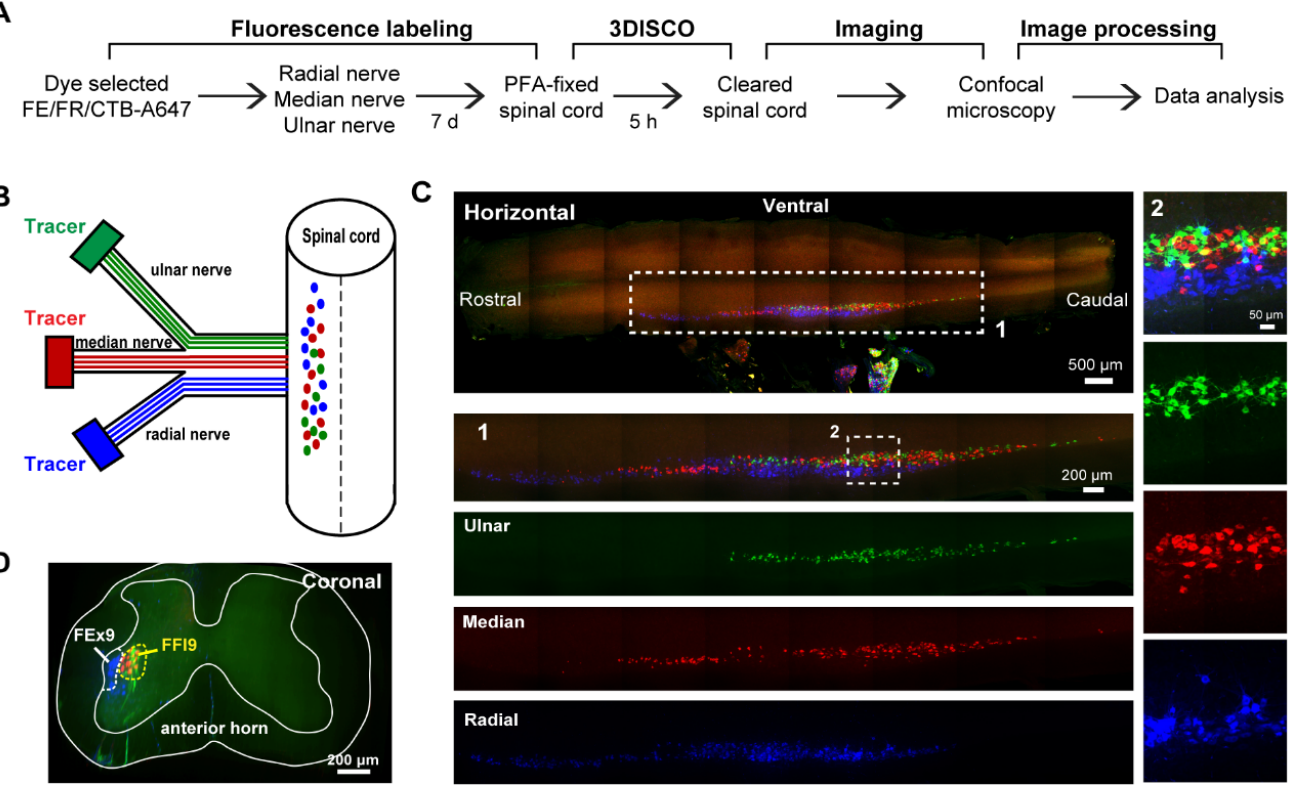
Figure 2. The 3D imaging of motor neurons of brachial plexus in the spinal cord. ( A ) The entire experimental process. ( B ) The screened tracers (FE, FR, and CTB-647) were used randomly to simultaneously label the ulnar, median, and radial nerves in the brachial plexus. ( C ) Maximum intensity z-projection of the image stacks of labeled motor neuron columns in the spinal cord. The enlarged images (10 × /0.5 objective) indicated by white dotted box 1 show the distribution of three motor neuron columns corresponding to ulnar, median, and radial, respectively. The more enlarged images (20 × /0.8 objective) indicated by white dotted box 2 show the motor neurons’ detailed morphology. ( D ) The distribution of three different motor neuron columns in the anterior horn of the spinal cord.